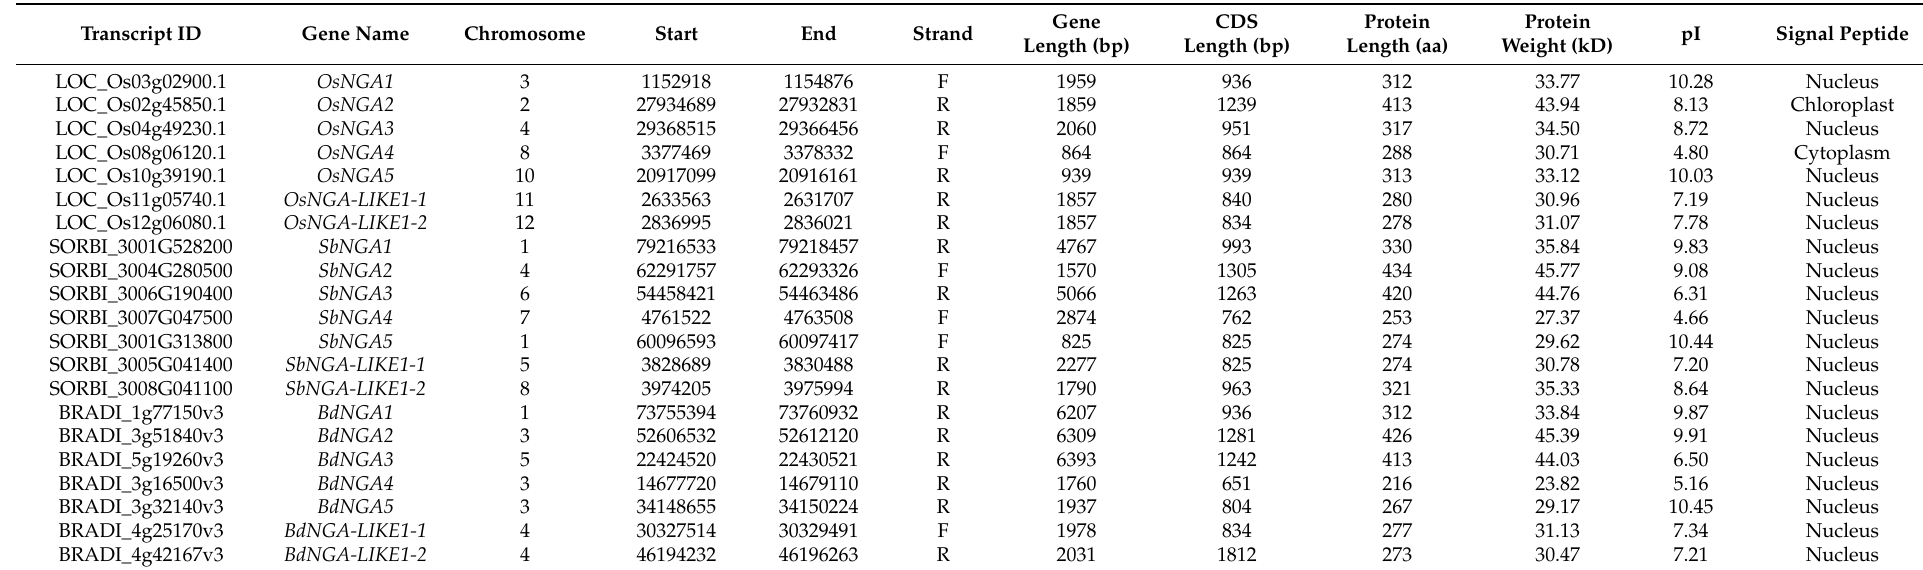
Table 2. The list of NGATHA genes in Poaceae ( O. sativa L. Japonica, B. distachyon , and S. bicolor ) and the features of each gene and